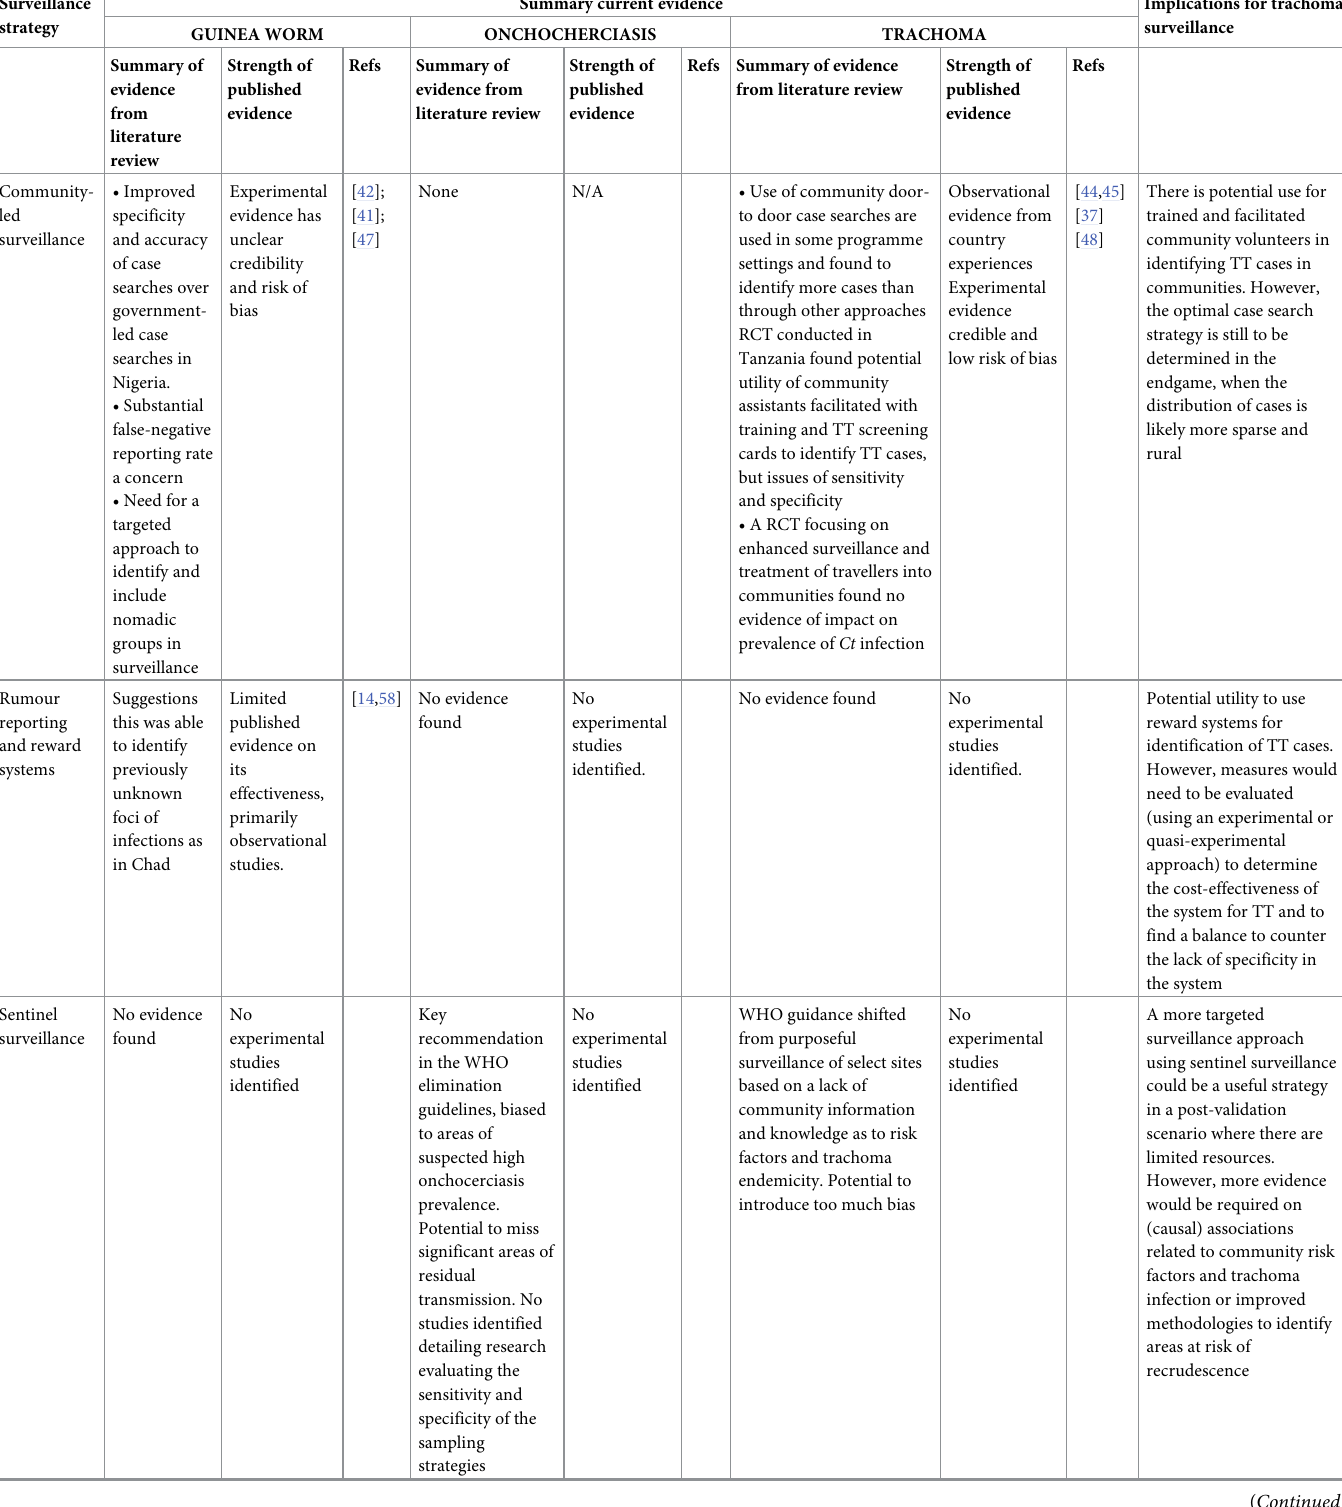
Table 3. Summary of studies evaluating evidence of surveillance strategies and implications for trachoma